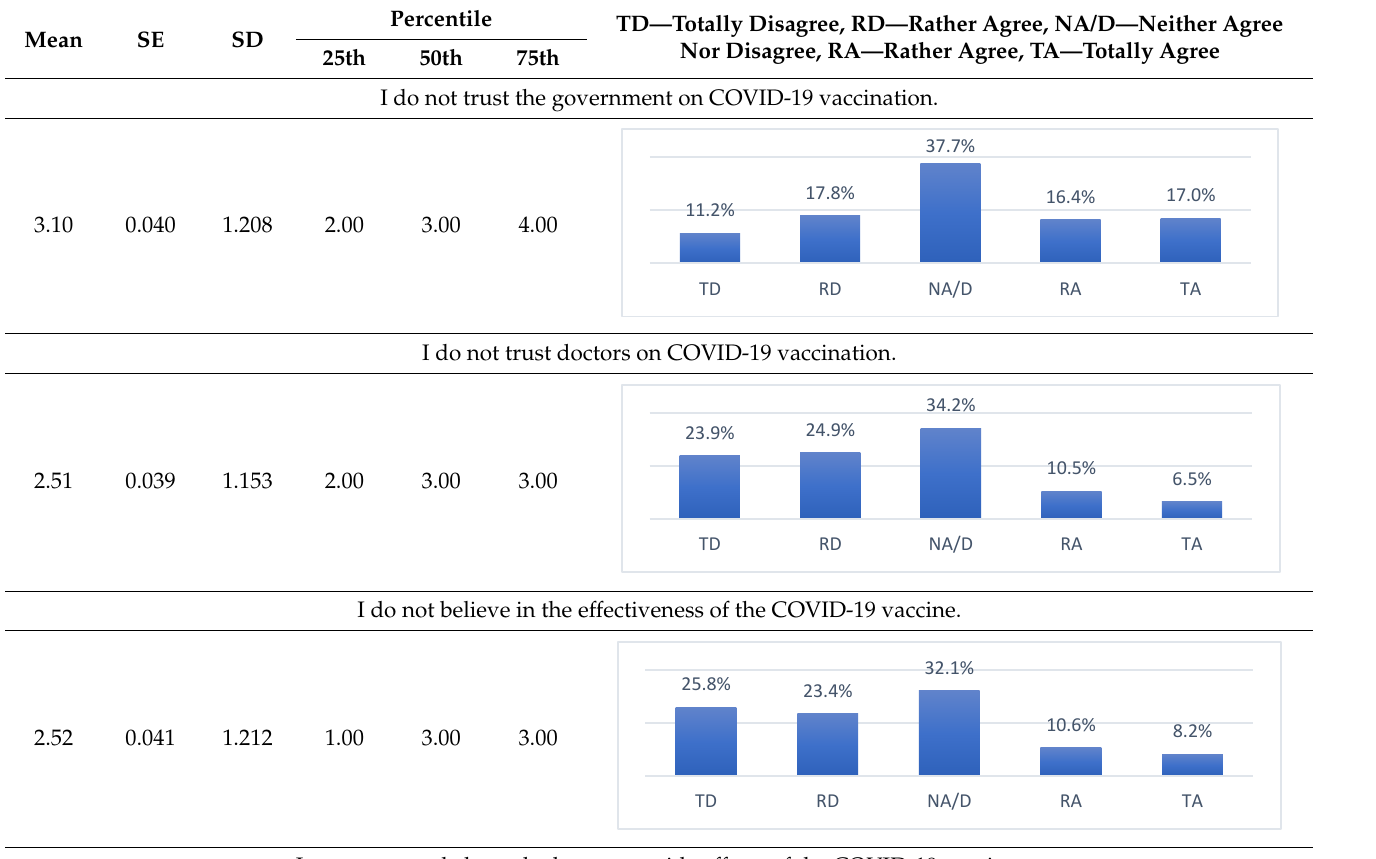
Table 9. Athletes ’ concerns and beliefs related to COVID-19 vaccination and COVID-19 pandemic broken town in terms of frequency ( n = 895).